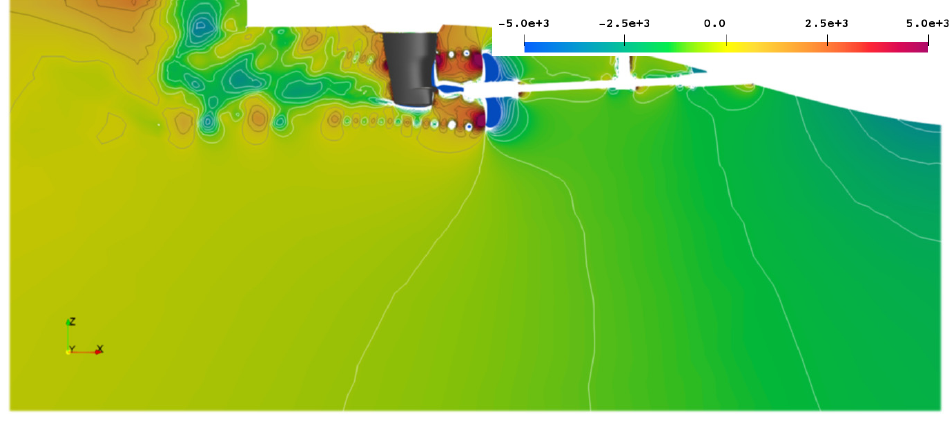
Figure 18. Instantaneous pressure pulses 𝑝′ in [Pa] at arbitrary converged timestep on the mid-plane.